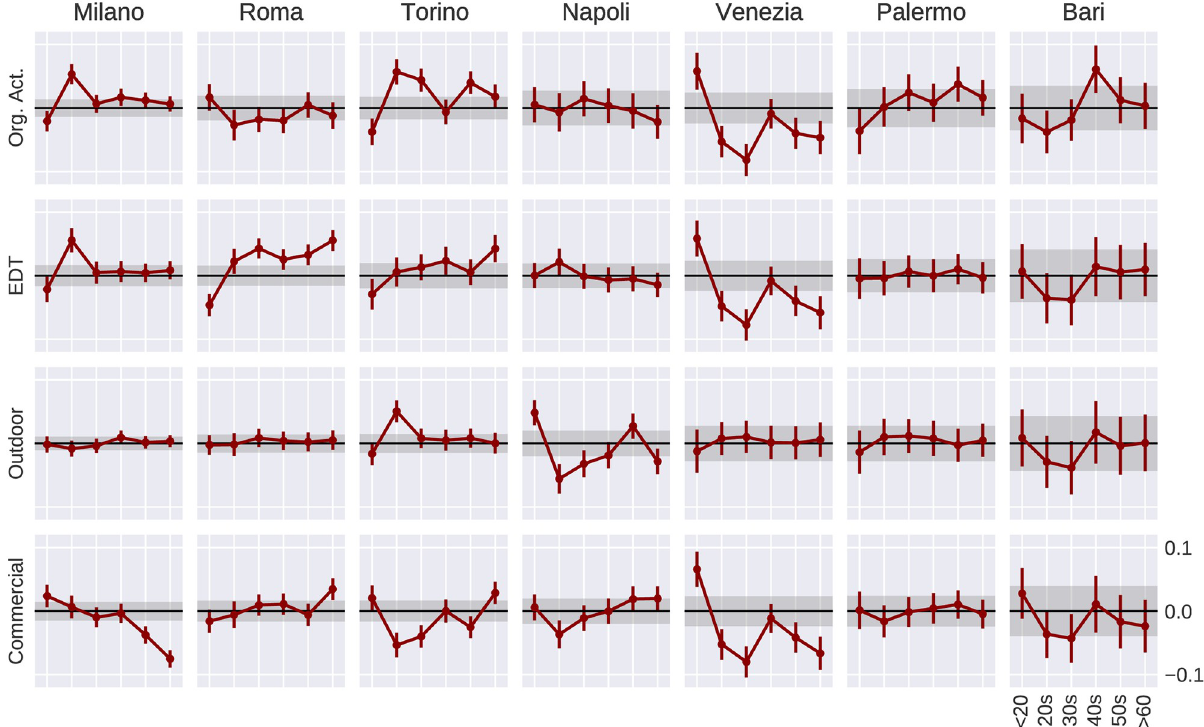
Fig 4. Age group differences in an univariate spatial error model of third places . For each city and each age group we run a univariate spatial error model where the dependent variable Y is the vibrancy, and the independent variable X is one of the categories of third places at a time. Similar to Fig 3, we firstly run the same model for the aggregated case (all ages) and subtract the resulting coefficient from each age group. X and Y axes are all the same across small multiples, and labels are only displayed in the bottom-right subplot. All values have been standardised subtracting the mean and dividing by the standard deviation before running the univariate model. Straight lines along zero indicate no variation across age groups. The error bars are provided by the spatial model result. The grey bands around zero indicate the error of the aggregate value. Milan, Rome and Turin are the cities with higher number of cells (and populations) and more significant patterns. An equivalent plot using the spatial lag model can be found in the S1